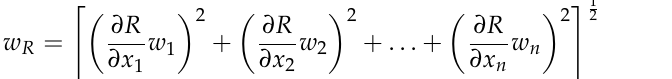
Table 4. Accuracies of the measurements and the uncertainties of the calculated quantities.